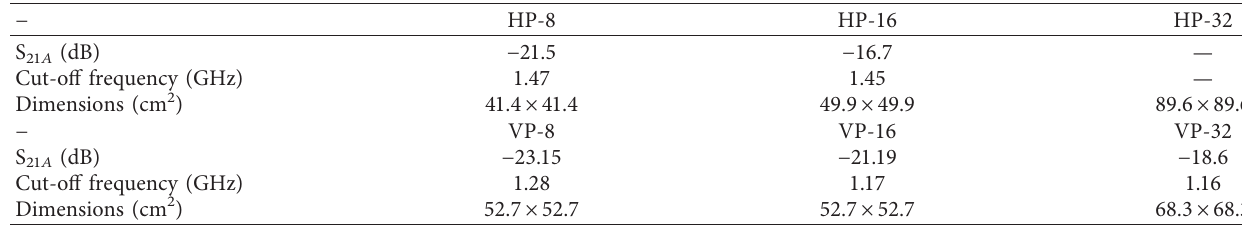
Table 4: Main performances of both horizontal and vertical polarization arrays.